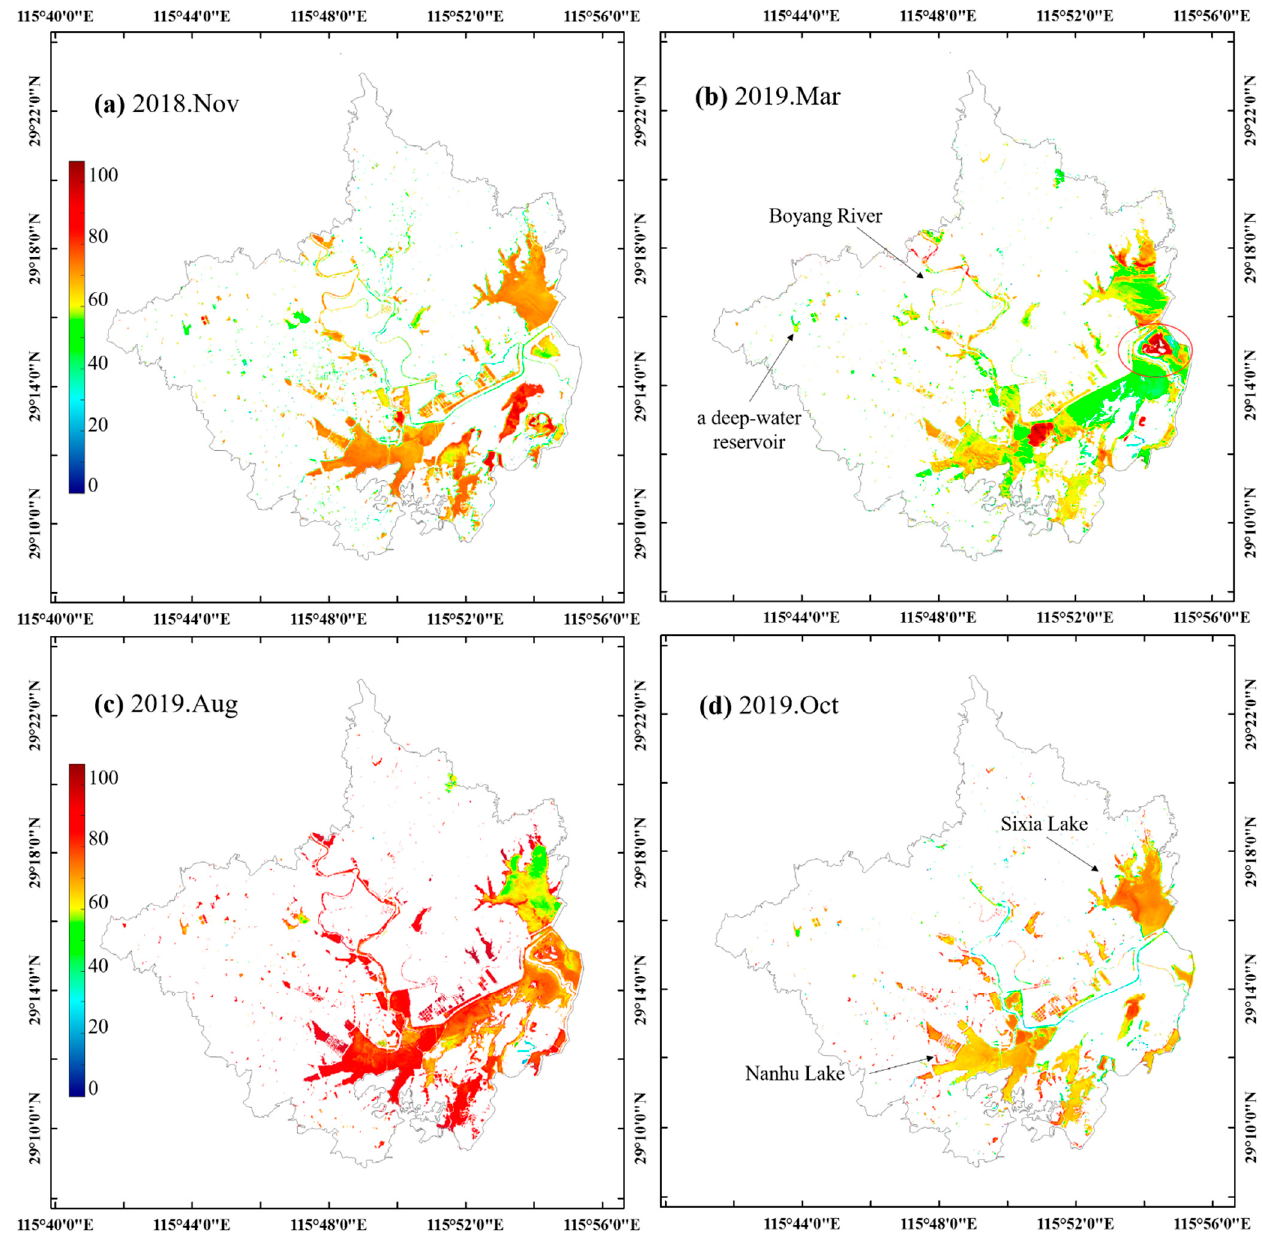
Figure 10. Temporal and spatial distribution of trophic state in Gongqingcheng urban waters. The TSI values modelled for urban water bodies in Gongqingcheng City displayed a seasonal pattern of lower values in winter and higher values in summer. This conforms to apparent seasonal variations in nutrient levels; examples of the latter include TP, TN, and Chl-a. Additionally, lower trophic levels were observed in rivers and reservoirs than in